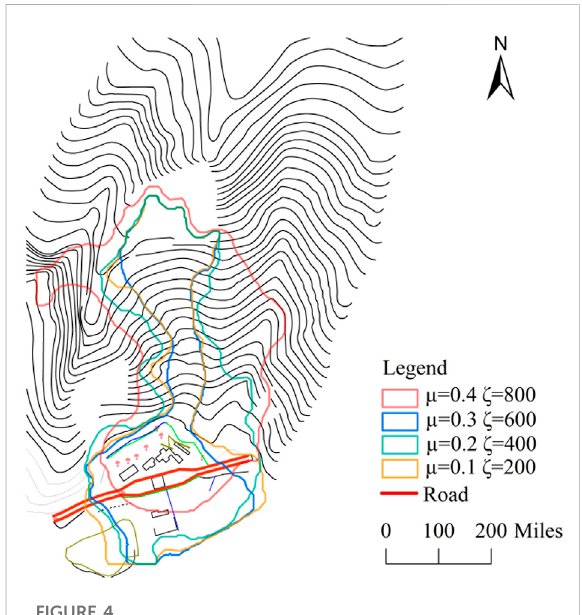
FIGURE 4 In fl uence of various friction coef fi cients on the accumulation range observed during debris fl